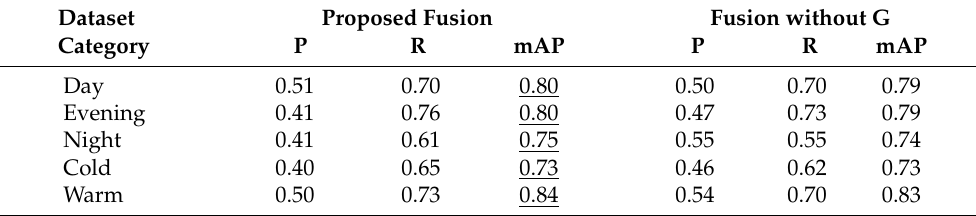
Table 3. Comparison of proposed fusion with and without considering the conditional variable.